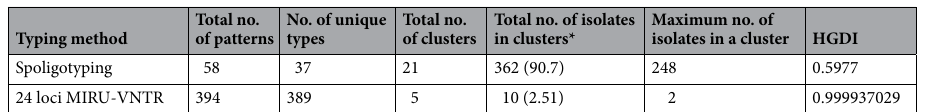
Table 3. Hunter Gaston Discriminatory Index (HGDI) and cluster results based on MIRU-VNTR loci analysis of 399 Mycobacterium tuberculosis complexes (MTBC) isolate from Sikkim. *Values are in %.